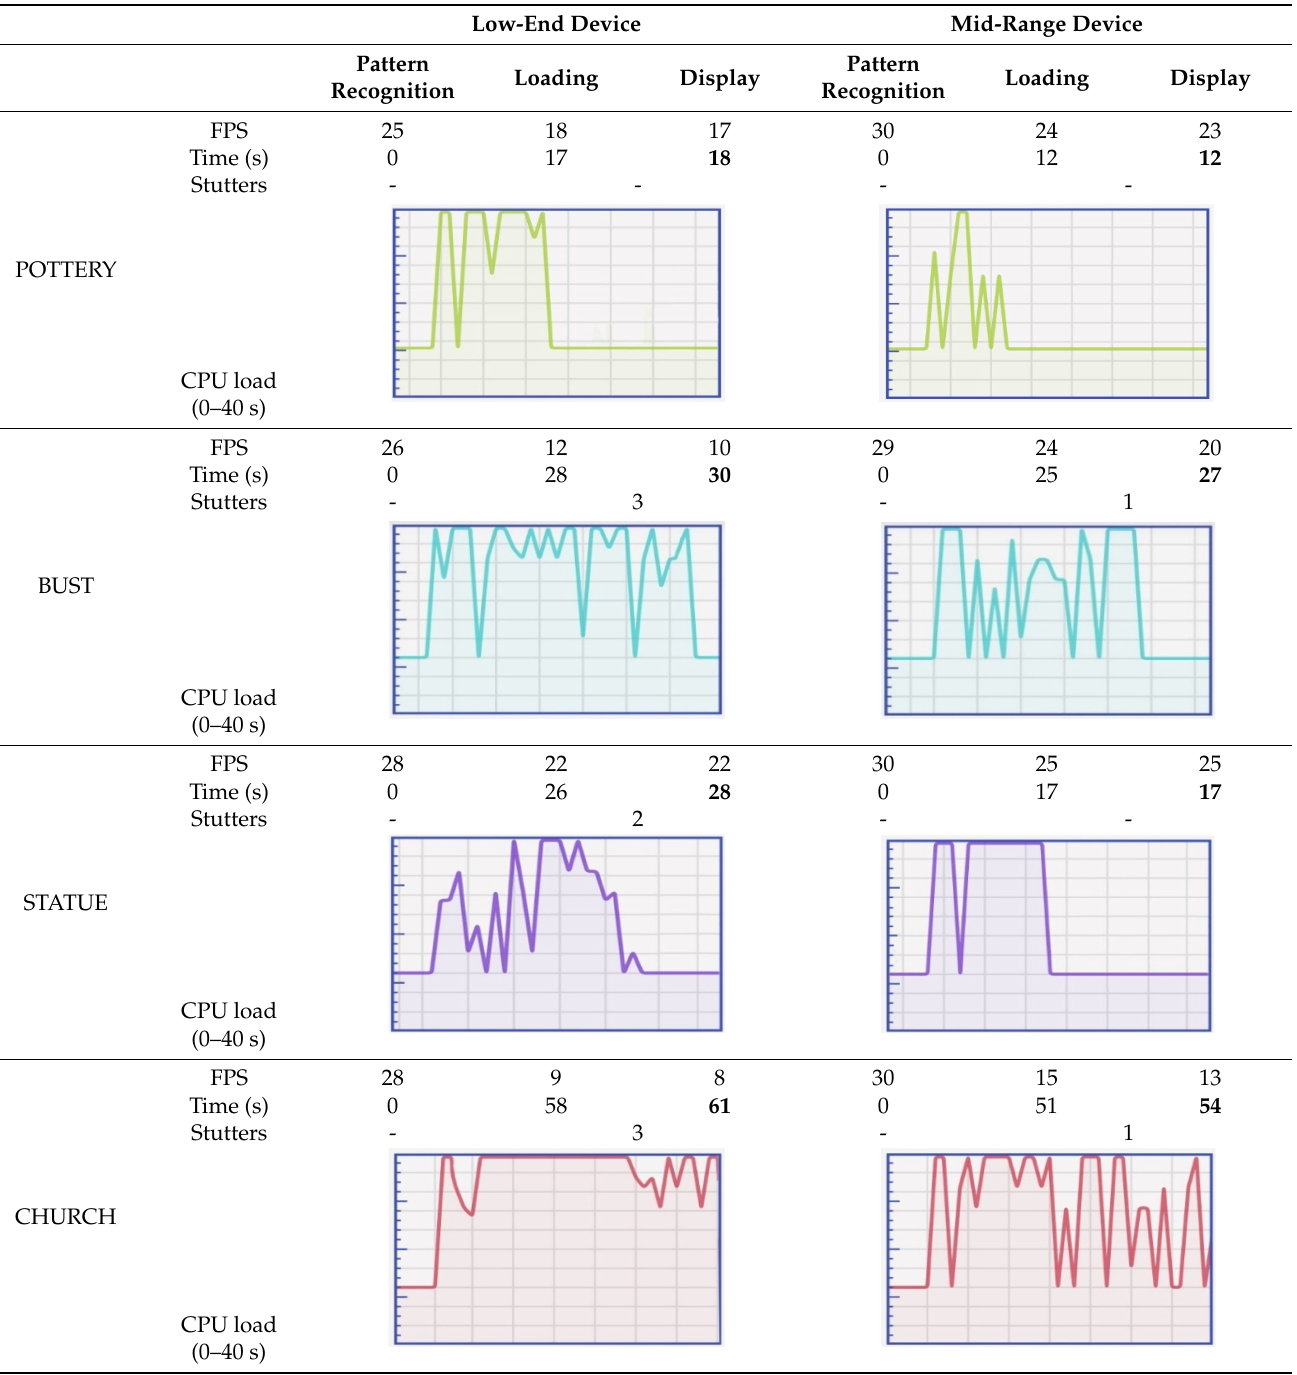
Table 9. GPU performance and CPU profiling results during the graphics computations of four AR sessions, one for each 3D model, on the low-end and the mid-range device: average frame rates, timing (total time is highlighted), stutters as well as graphs of real-time CPU usage of 40 s duration after pattern is recognized and pose tracking is